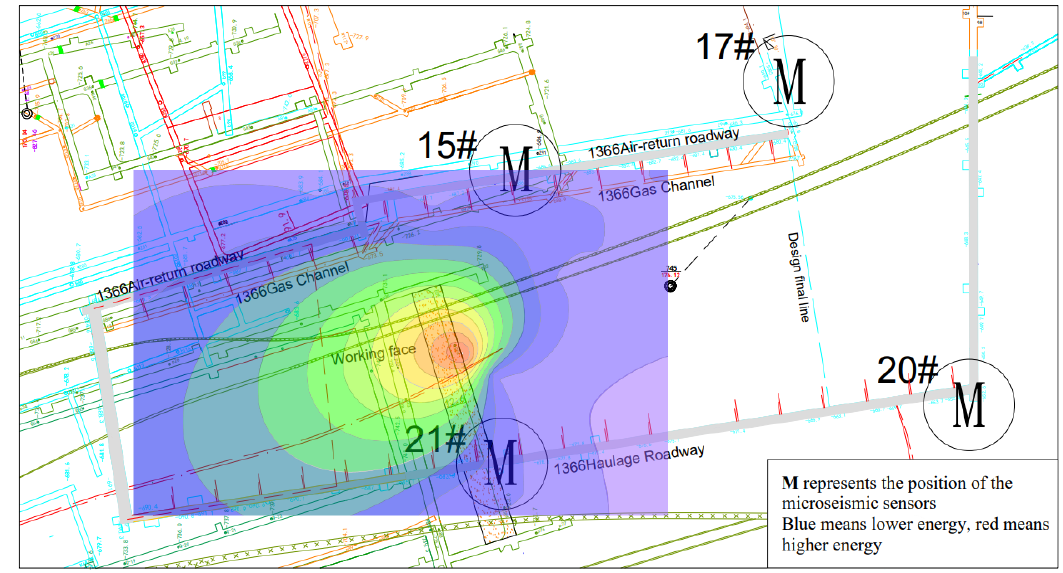
Figure 4. Cloud chart of microseismic energy of 1366 working face.